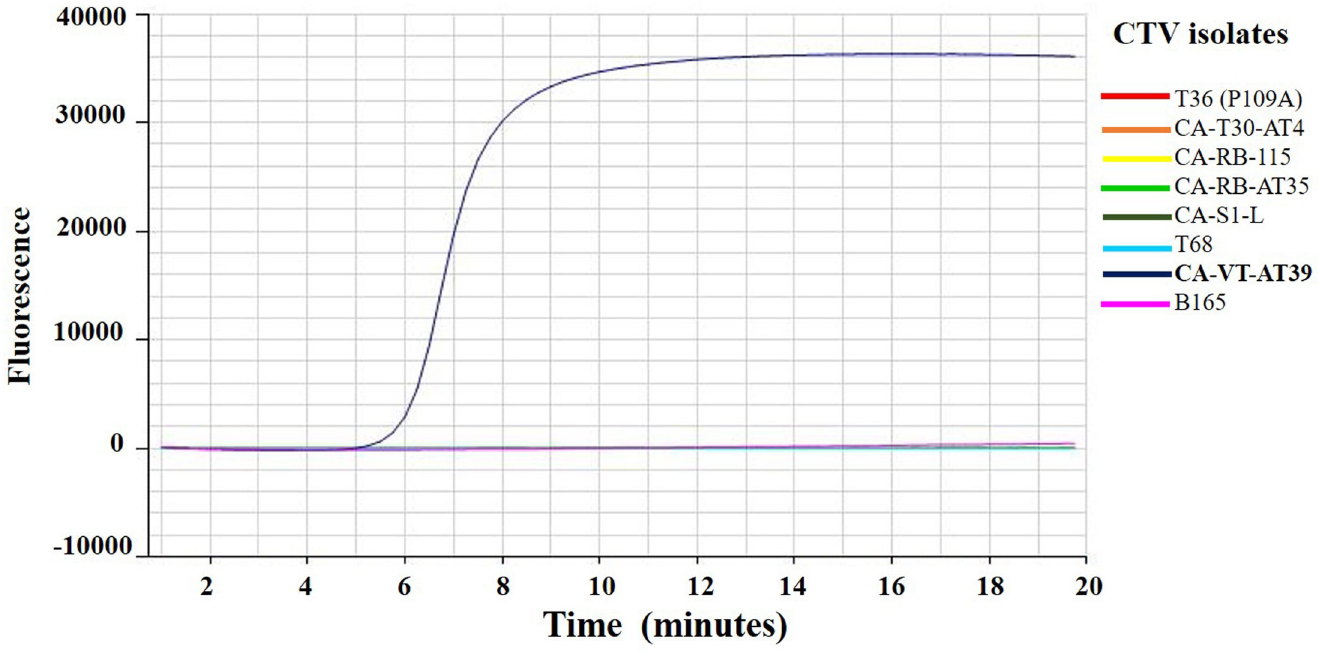
Fig 3. Amplification curves of eight Citrus tristeza virus (CTV) isolates RNA belonging to different genotypes using RT-LAMP assay. Amplification curves of CTV isolates T36 (P109A), CA-T30-AT4, CA-RB-115, CA-RB-AT35, CA-S1-L, T68, CA-VT-AT39, and B165 using RNA extracted from infected citrus leaves in the RT-LAMP assay. CA-VT-AT39 RNA detection time was 5:58 (min:sec) and no amplification was observed with other strains.